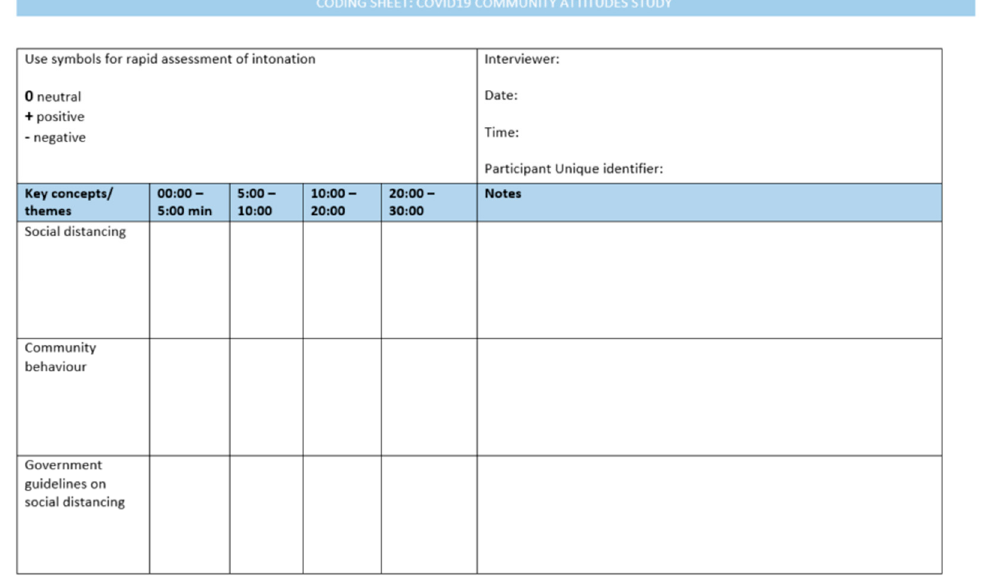
Figure 1. Coding Template (Adapted from Neal et al. [29] ).